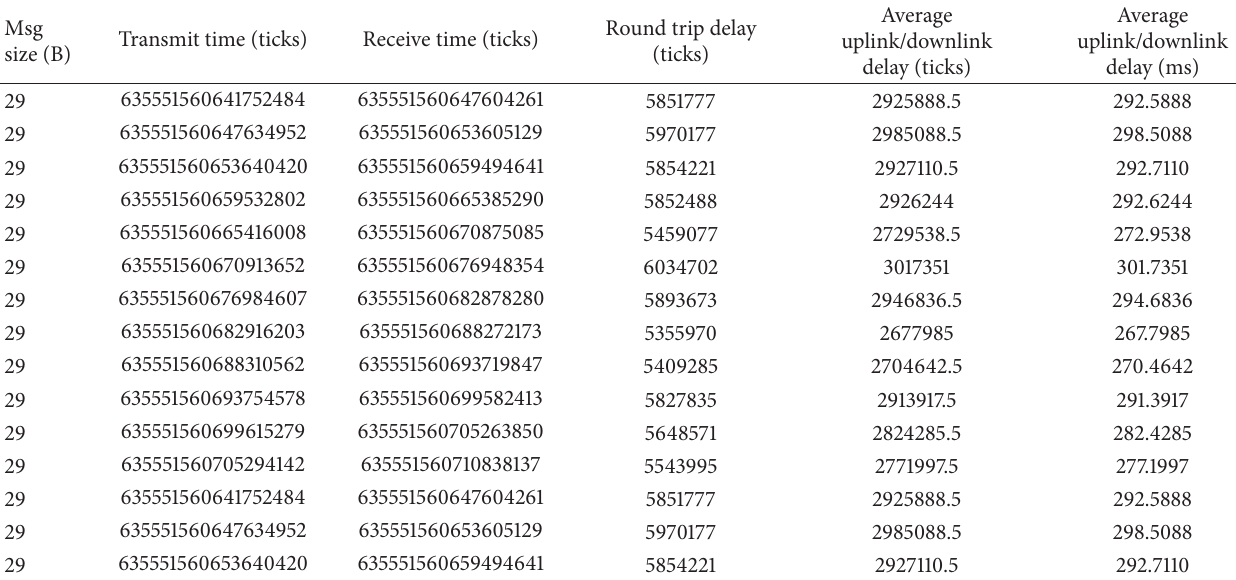
Table 3: GSM communication delay measurements.